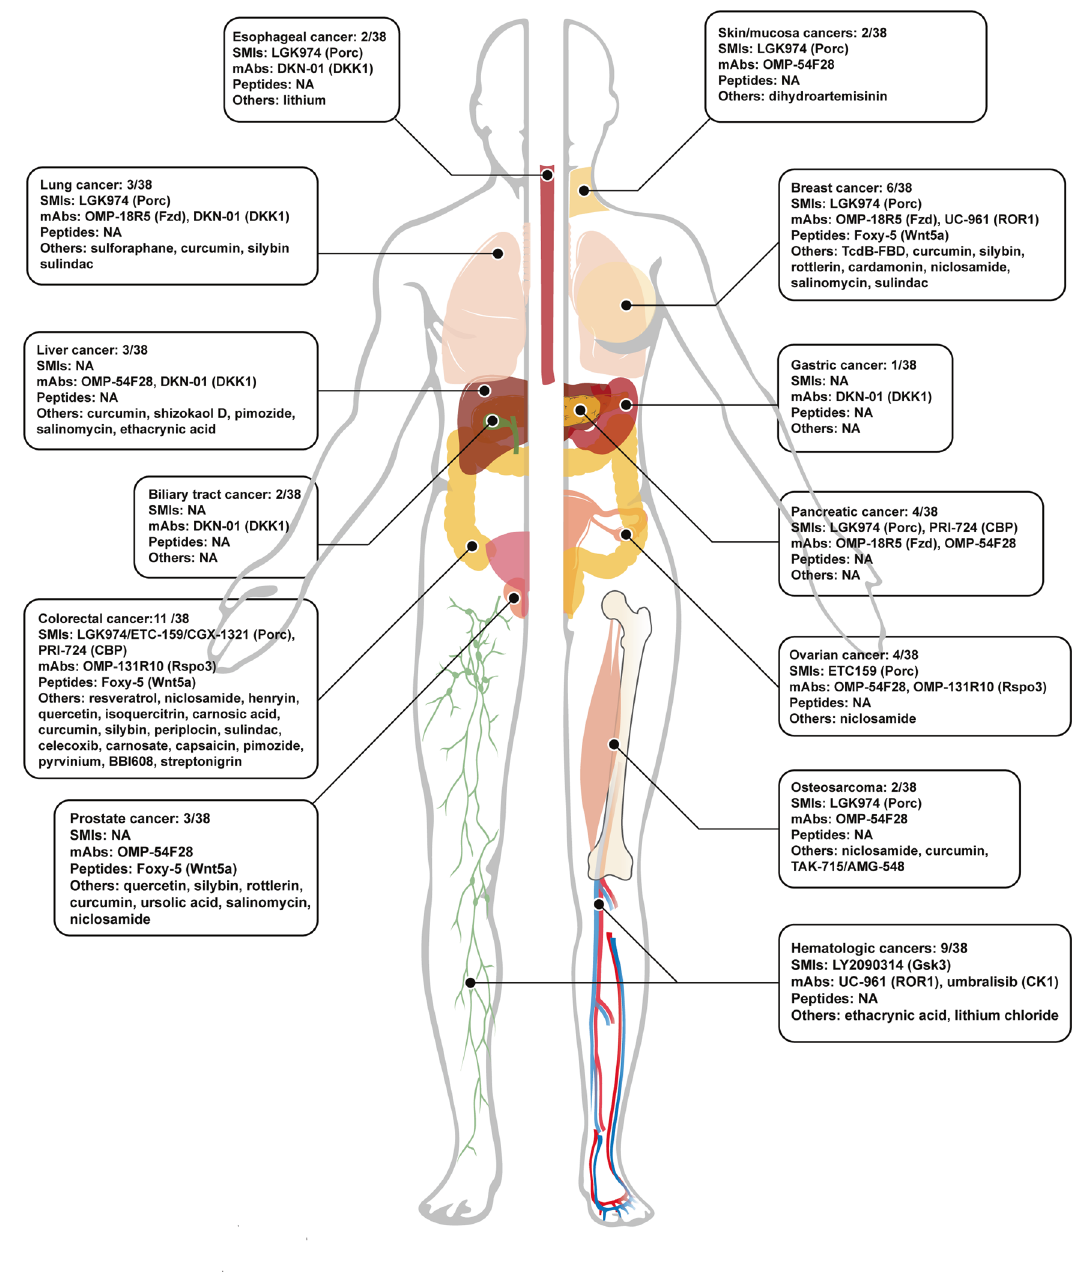
Fig. 6 The overview of status quo registered clinical trials of Wnt/ β -catenin signaling-dependent targeted therapies in cancers (updated in May 2021). Within the boxed diagram, the fi rst lane provided the numbers of clinical trials for the speci fi c type of cancers in all clinical trials. From the second to the fi fth lane, we provided the types of drugs as SMIs, mAbs, Peptides, and others, and the parts that follow the colon indicted the names of drugs and the targeted components of Wnt/ β -catenin signaling were shown in the